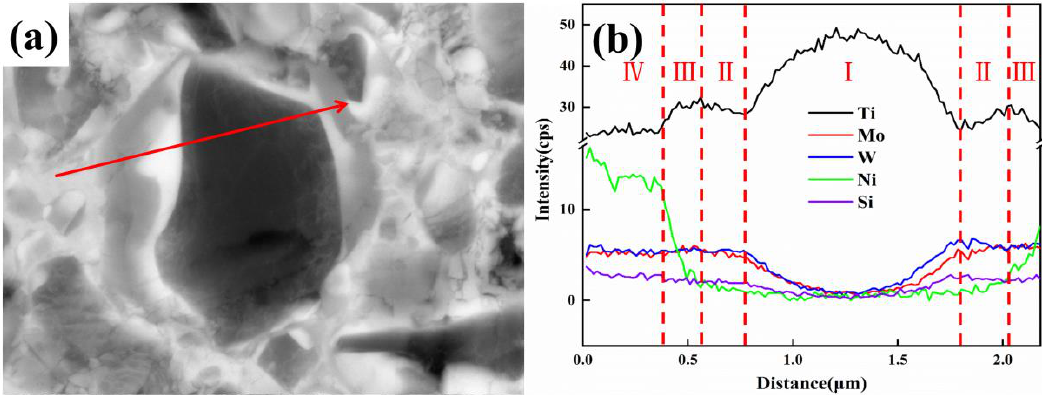
Figure 5. ( a ) The SEM of cermets C with 2.0 wt.% SiC p ; ( b ) EDS line scanning results.